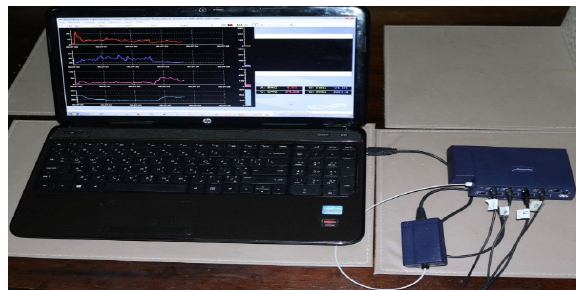
Figure 1. Stages for an Offline myoelectric pattern recognition system.